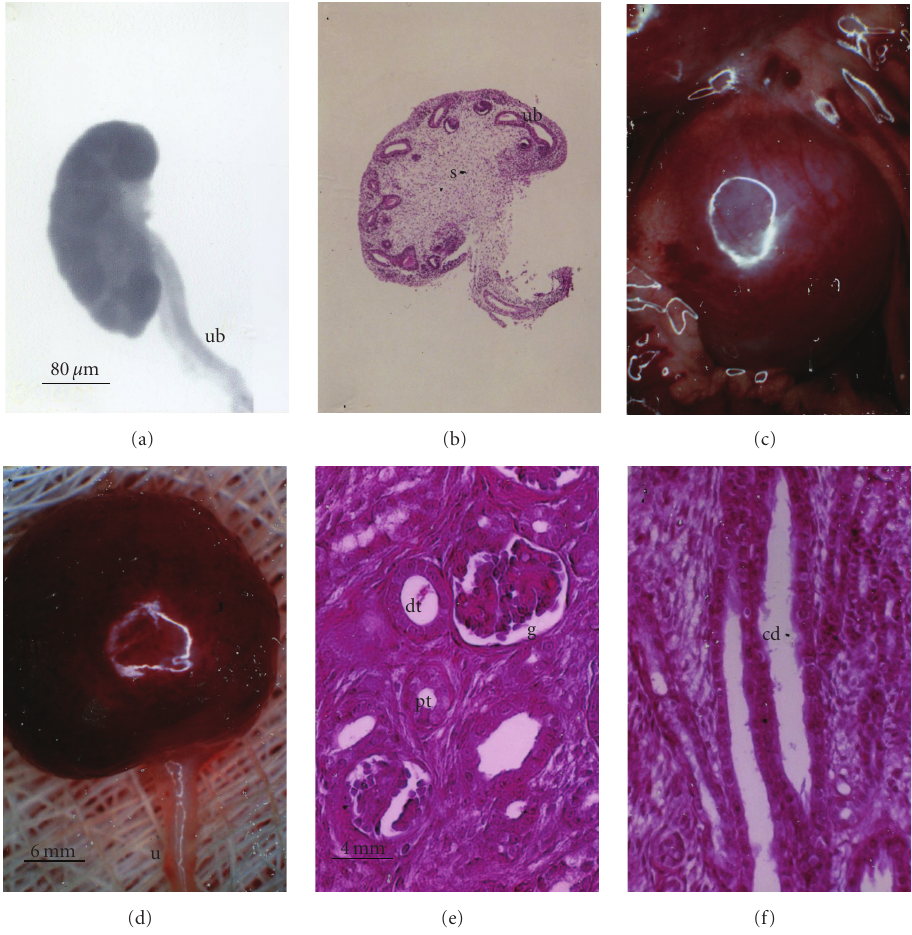
Figure 1: Photographs (a, c, d) and photomicrographs (b, e, f) of E28 pig renal primordia (a, b) or E28 pig renal primordia 7 weeks after transplantation into the mesentery of a rat (c–f). (a) E28 primordium (ub, ureteric bud); (b) E28 primordium (s, stroma; ub, ureteric bud); (c) E28 pig renal primordium 7 weeks after transplantation in a rat mesentery; (d) E28 pig renal primordium after removal from the mesentery (u, ureter), (e) Cortex with a glomerulus, (g) proximal tubule (pt), and distal tubule (dt) labeled; (f) Medulla with collecting duct (cd) labeled. Magnifications are shown for (a) and (b) (in (a)); (c) and (d) (in (d)); (e) and (f) (in (e)) reproduced with permission [8].